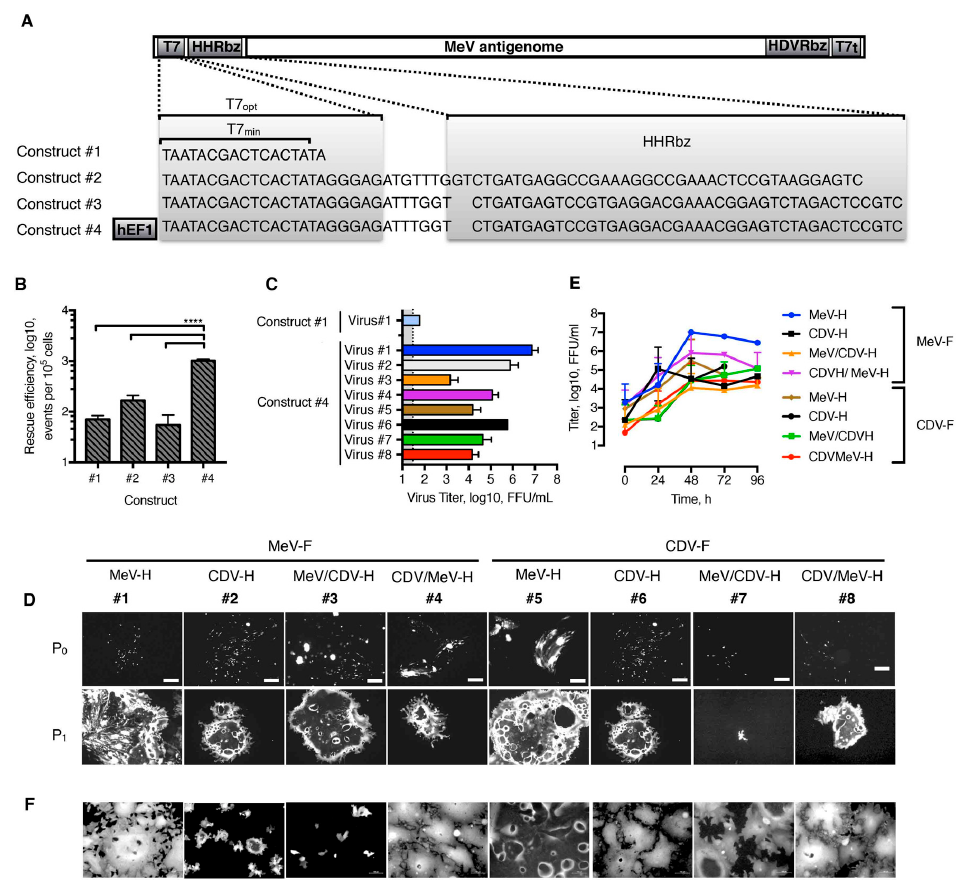
Figure 4. Rescue and in vitro characterization of chimeric viruses. ( A ) Sequence of the T7 promoter, variable sequence, and HHRbz tested in the context of the plasmid carrying the MeV antigenome.